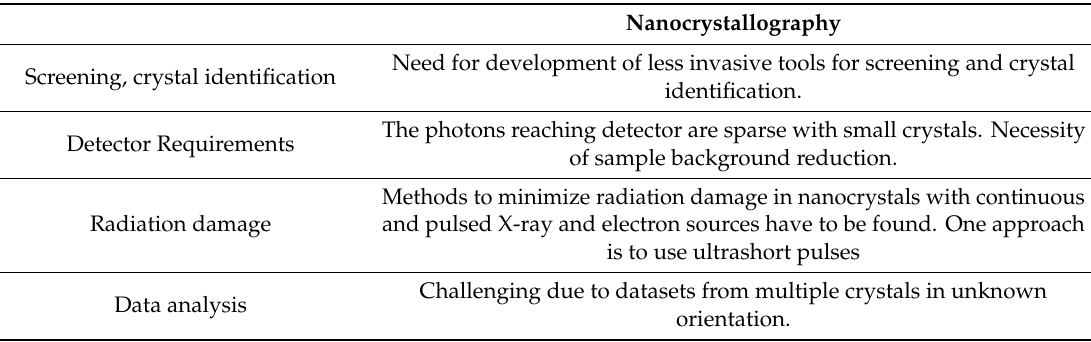
Table 1. Challenges in